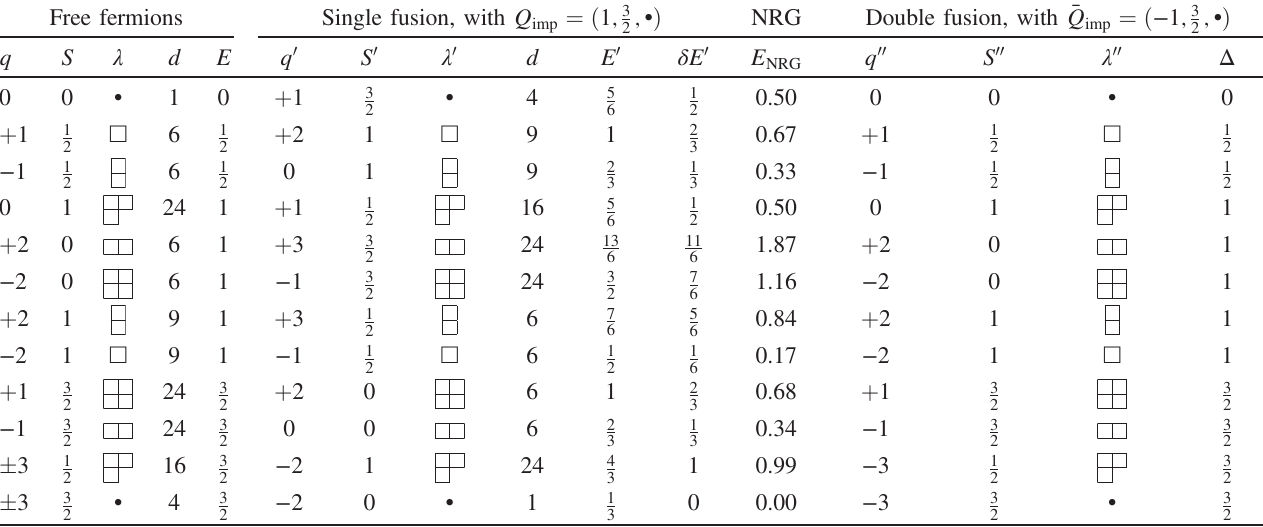
TABLE III. Fusion table for spin screening at the FL fixed point c (cid:4) of the 3soK model. It has the same structure as Table II, but here FL single fusion of bath and impurity multiplets in the charge and spin sectors is performed using U ð 1 Þ × SU ð 2 Þ 3 fusion rules (listed in 1 ; 3 ; (cid:129) Þ for the impurity, representing the effective local degree of freedom Table S3 of the SM [54]). Moreover, we choose Q 2 imp ¼ ð obtained after the completion of orbital screening. The resulting multiplets ð q 0 ; S 0 ; λ Þ have eigenenergies E 0 ¼ E ð q 0 ; S 0 ; λ Þ and excitation . The NRG energies, computed for ð J 0 ; K 0 ; I 0 Þ ¼ ð 10 − 4 ; 0 . 3 ; 0 Þ , have been shifted and rescaled such that the energies δ E 0 ¼ E 0 − E 0 min lowest energy is zero and the second-lowest values for E and δ E 0 match. The single-fusion and NRG spectra agree very well NRG (deviations ≲ 2% ).